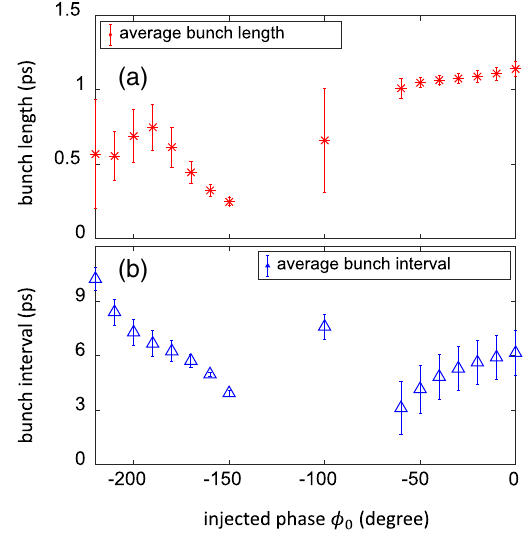
FIG. 12. Bunch lengths (a) and bunch intervals (b) with different injected phases ϕ 0 for 4 × 200 pC bunch